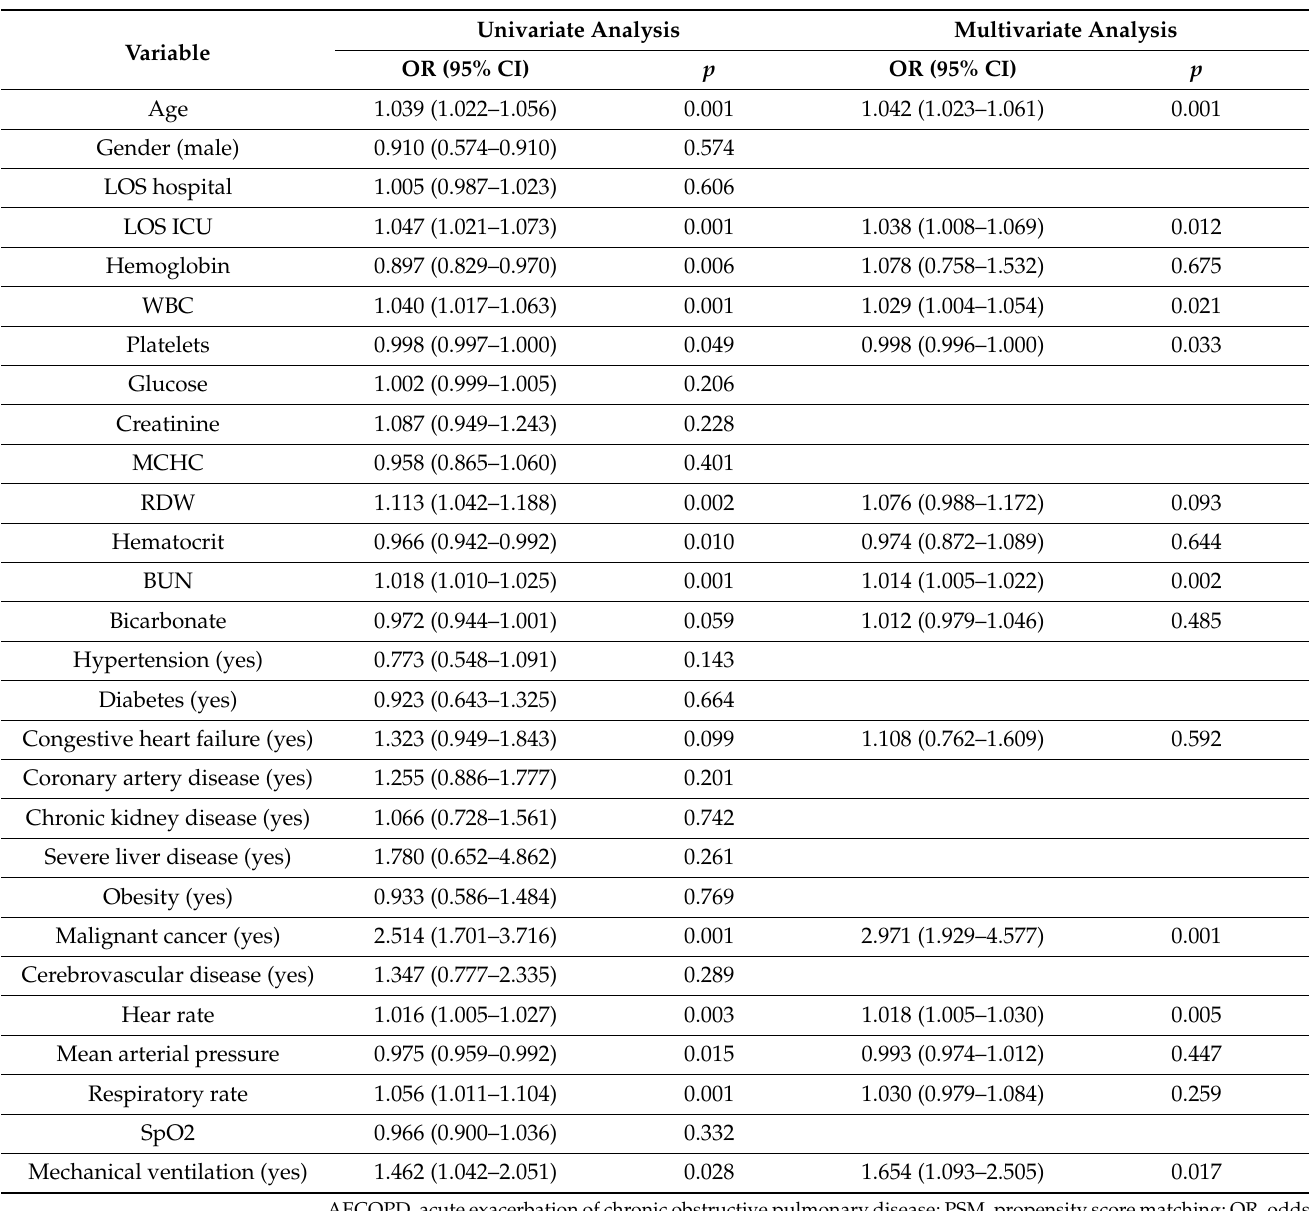
Table 2. Binomial logistic regression analysis of BUN for in-hospital mortality among critically ill patients with AECOPD (before PSM).